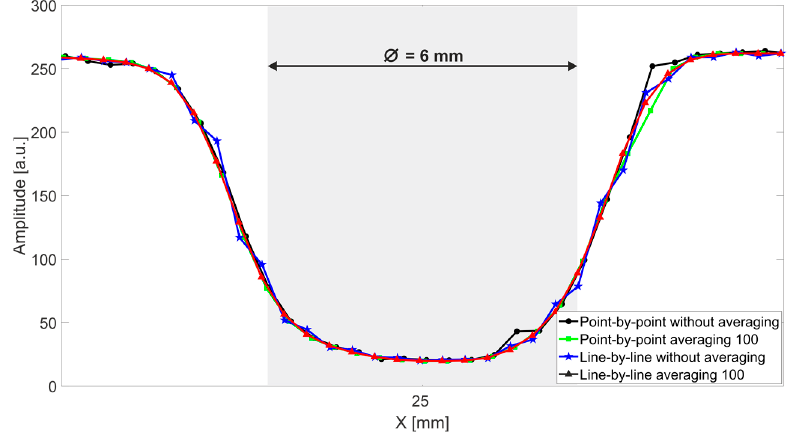
Figure 9. Peak-to-peak amplitude of the terahertz signal reflected along the line passing through the